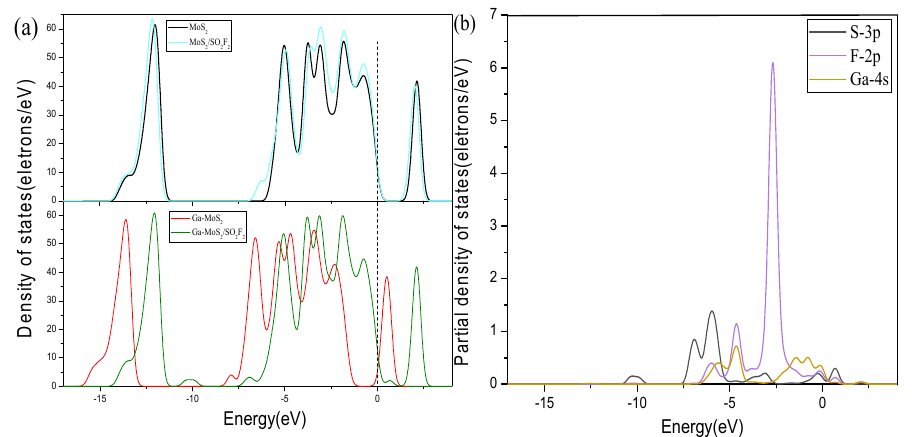
Figure 11. Comparative analysis of ( a ) DOS and ( b ) PDOS for SO 2 F 2 system. The dotted lines are Fermi level.